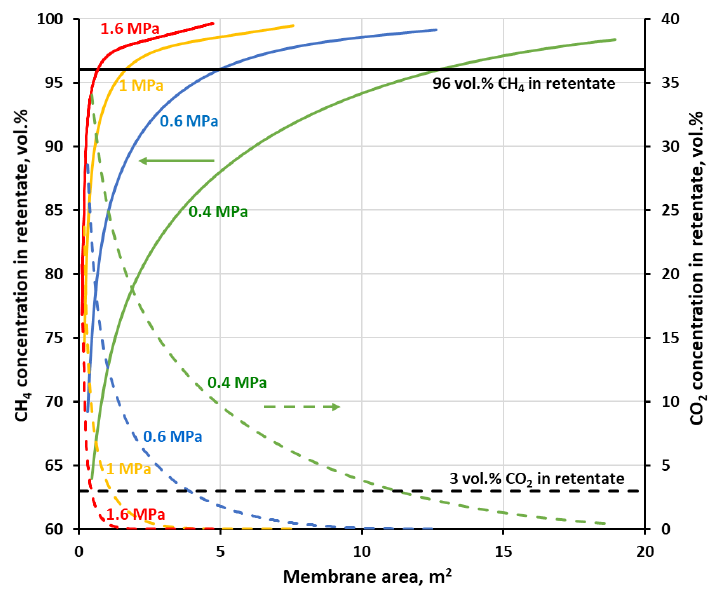
Figure 7. CH 4 (solid lines) and CO 2 (dashed lines) concentration in retentate against membrane area and feed gas pressure for a one-stage biogas upgrading system with the polyimide (UMS-A5) mem- brane.